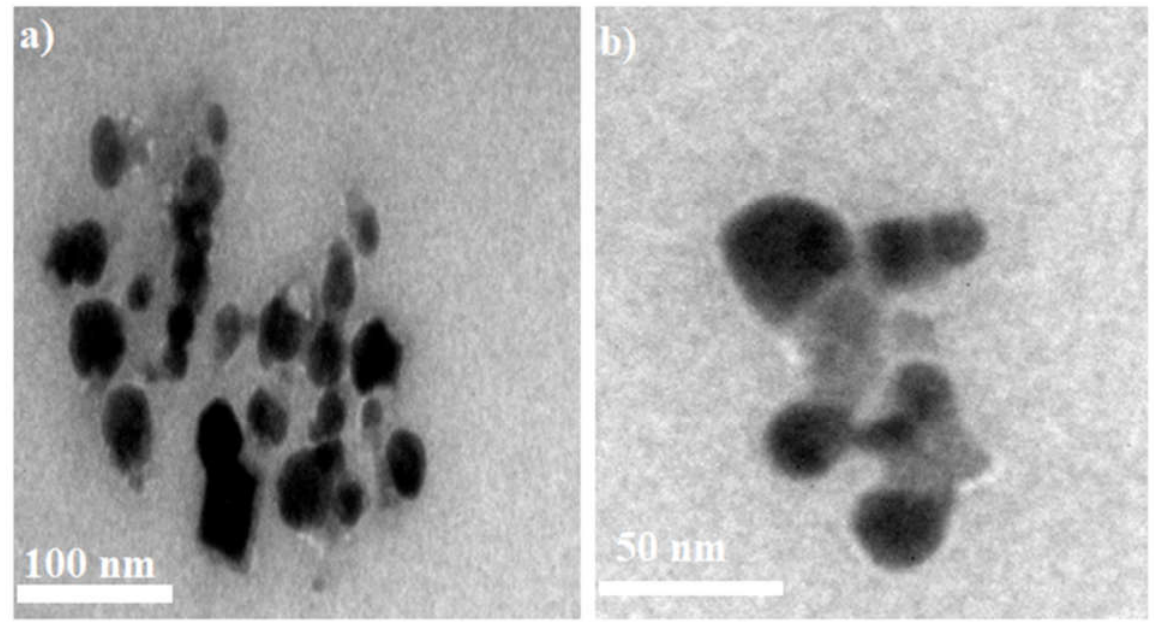
Figure 5. Different magnified TEM images of (( a )-100 nm and ( b )-50 nm) Co 3 O 4 nanoparticles.